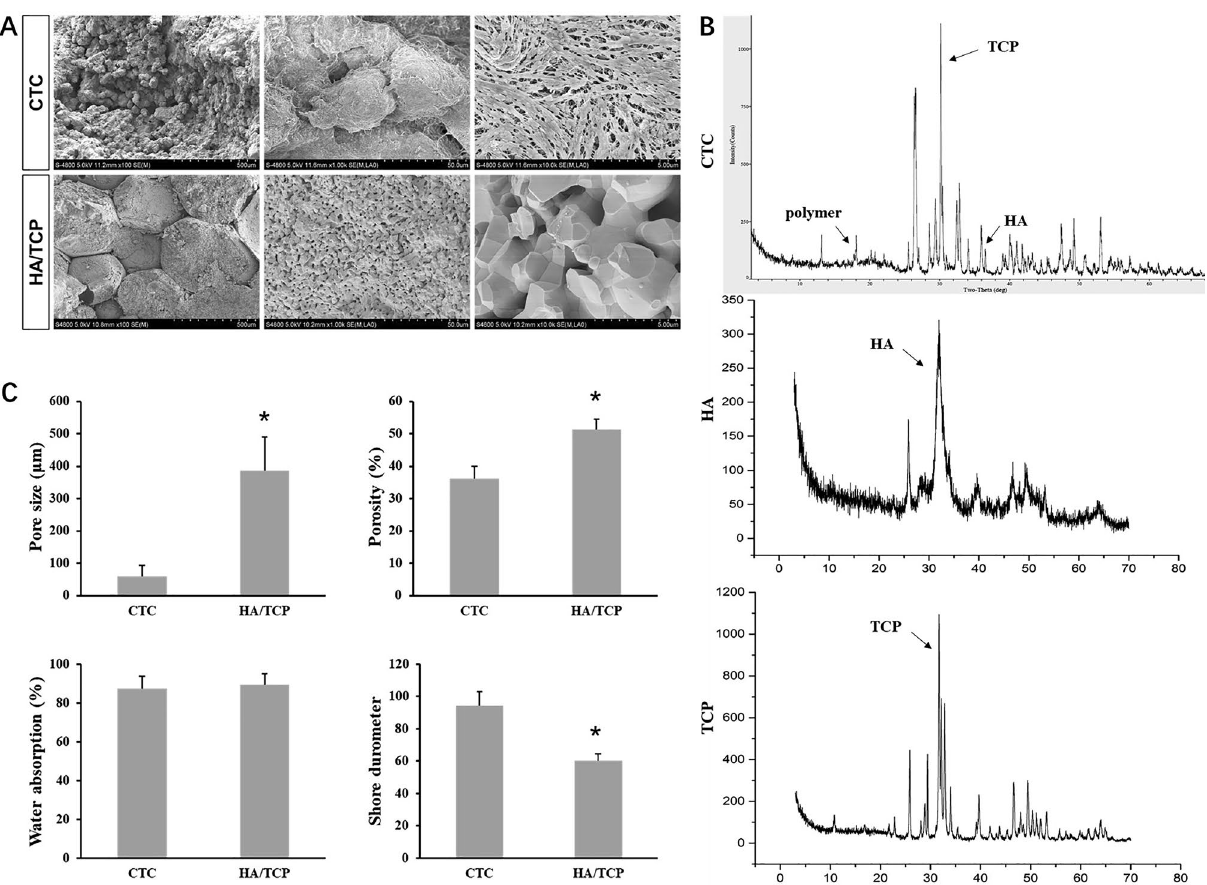
Figure 4. The physicochemical characteristics of the CTC and HA/TCP biomaterials. ( A ) The SEM pictures of the CTC and HA/TCP biomaterials with a magnification of 100, 1000 and 10,000 times. ( B ) The XRD spectrum of the CTC, HA and TCP materials indicated that the peaks represented polymer, HA and TCP, respectively. ( C ) Statistical data showed the pore size, porosity, water absorption and Shore durometer of the CTC and HA/TCP biomaterials, * P < 0.05.